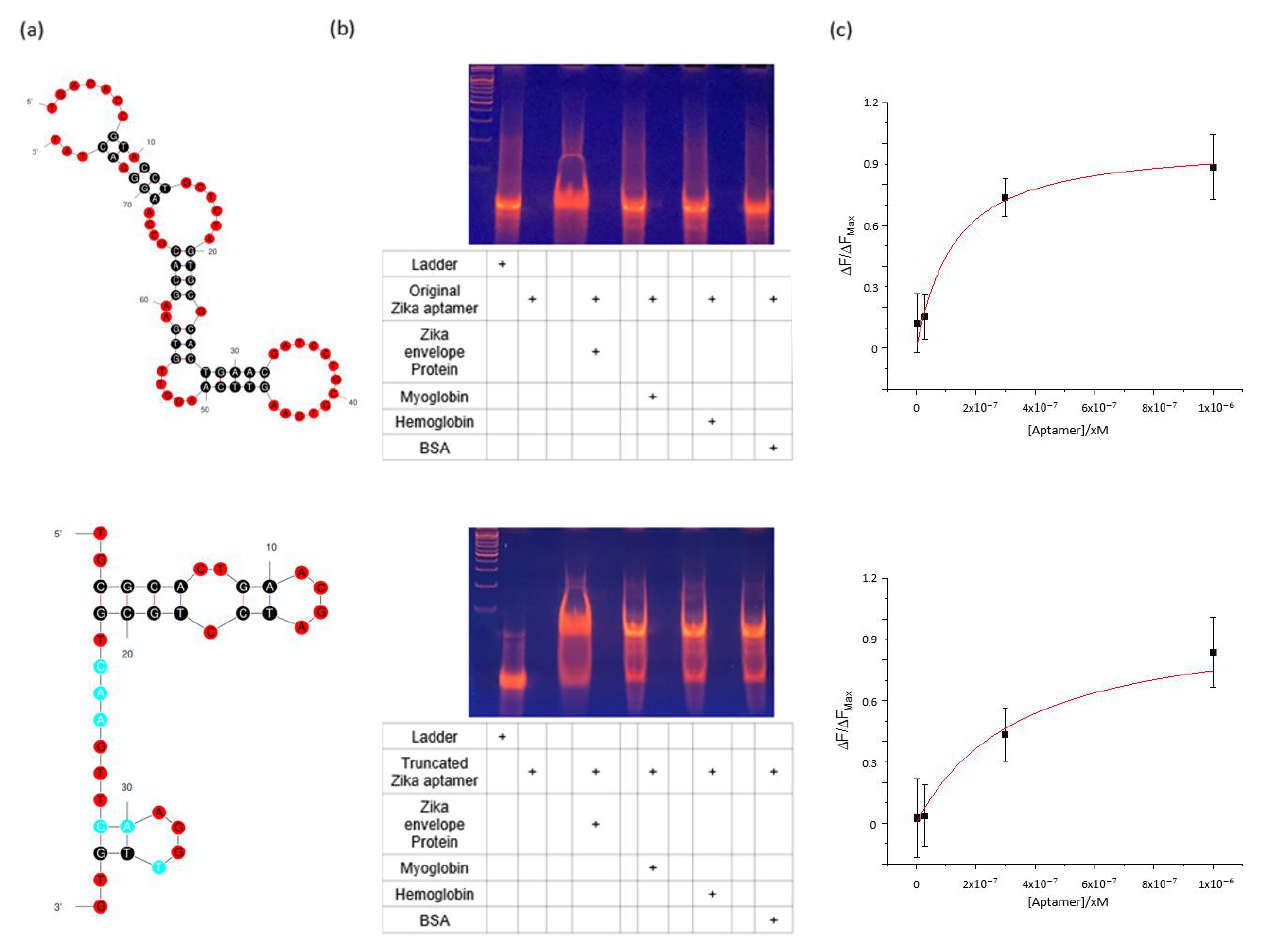
Figure 2. Comparison of the original and truncated Zika aptamers ( a ) Base structures of the original and truncated zika aptamers. ( b ) Result of 8% TBE-PAGE for the original and truncated Zika aptamers. ( c ) Binding affinity of the original and truncated Zika aptamers.